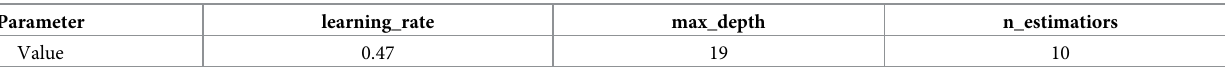
Table 4. XGBOOST super parameter combination of the model. Parameter